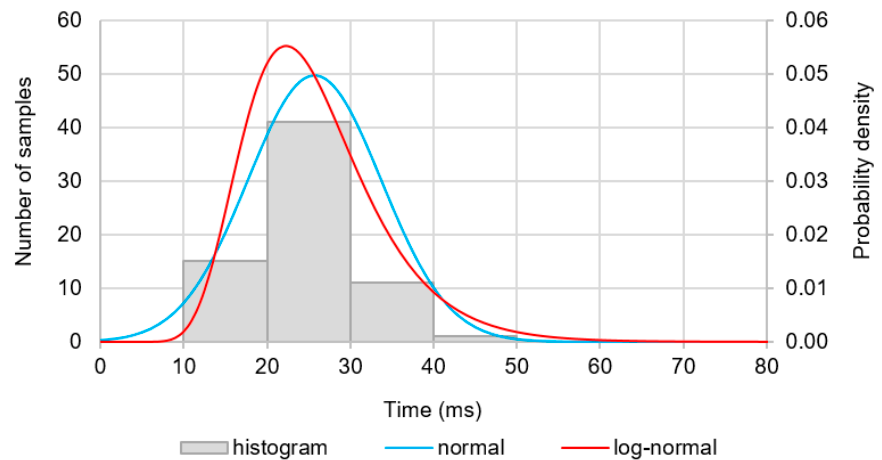
Figure 7. Histogram and the normal and log-normal operating time distributions for 7SA protection with instantaneous setting.